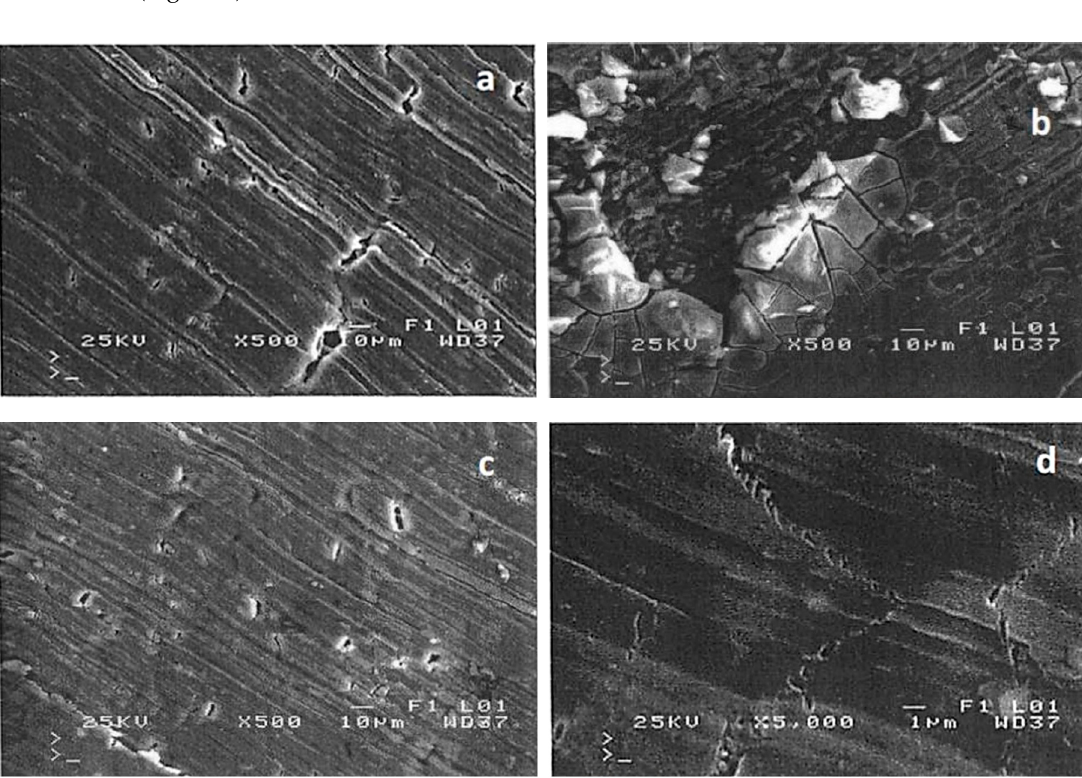
Figure 7. X-ray diffraction (XRD) analysis of the surface of T6 treated 6082 aluminum alloy, after SSRT testing in ( a ) air, ( b ) pH = 3, ( c ) pH = 7 and ( d ) pH = 10. From the fractographic analysis of the samples after SSRT testing it is evident that the change in pH resulted in different surface morphologies. To get a better insight into the effect of corrosion on the surface of 6082 aluminum alloy and to better understand the synergism between corrosion and wear, potentiostatic corrosion experiments were performed. Figure 8 shows the evolution of open circuit potential (OCP) of T6 treated 6082 aluminum alloy as a function of immersion time, for the three examined pH values of 0.3 M sodium chloride (NaCl) aqueous solution. From this figure, it can be observed that the OCP of the specimens at pH = 7 and 10 was more noble than that of pH = 3. Indeed, it is known that the pH of the corrosion environment can affect the stability of the oxide film (Al 2 O 3 ), according to the Pourbaix diagram [28]. In particular, in neutral pH values a stable Al 2 O 3 oxide film is formed, passivating 6082 aluminum alloy and hindering the diffusion of the Cl − halide ions. Therefore, the corrosion phenomena are more intense in the acidic pH, when compared to neutral. In addition, hydrogen uptake will occur in an environment with alkaline pH [29]. However, it should be also taken into consideration that stress corrosion cracking involves the synergism between electrochemical and mechanical aspects. For example, mechanical stresses can accelerate the diffusion of halide and/or hydrogen ions enhancing corrosion and/or embrittlement phenomena [30]. On the other hand, the formation of corrosion products and surface defects (e.g., pits, blisters) are known to degrade the mechanical performance of materials [27].